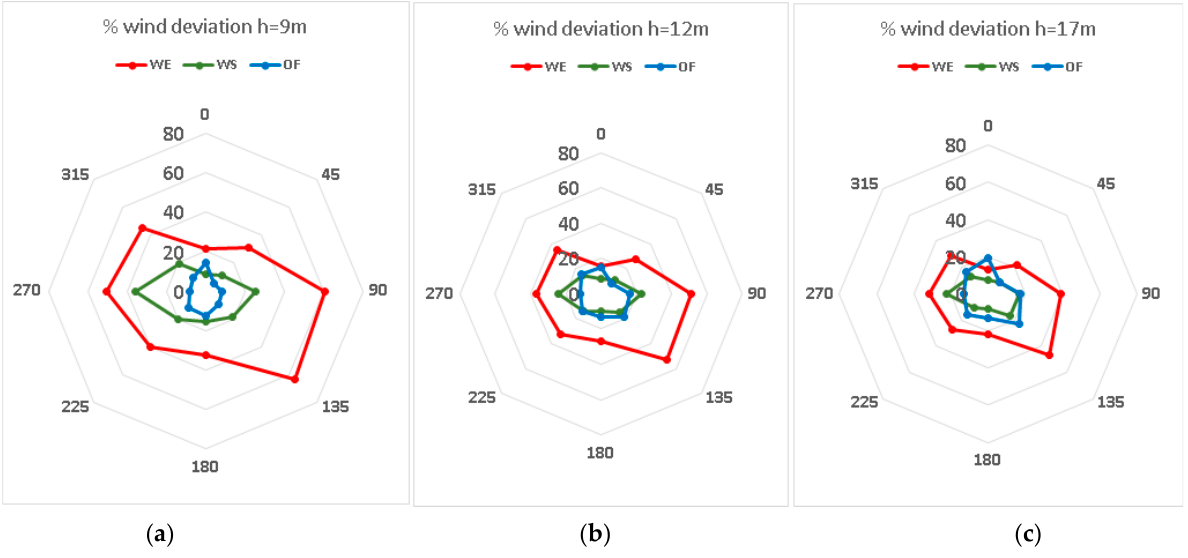
Figure 29. Overall mean wind speed absolute deviation per points 1, 2, 3 and per height ( a )—9 m, ( b )—12 m, and ( c )—17 m above ground.